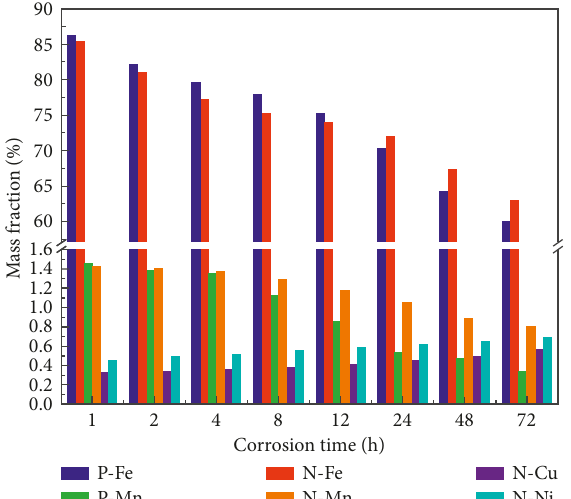
Figure 9: Comparison of elemental content on the surface of two steels, P-Fe and P-Mn are Fe and Mn of carbon steel, and N-Fe, N-Mn, N-Cu, and N-Ni are Fe, Mn, Cu, and Ni of weathering steel,